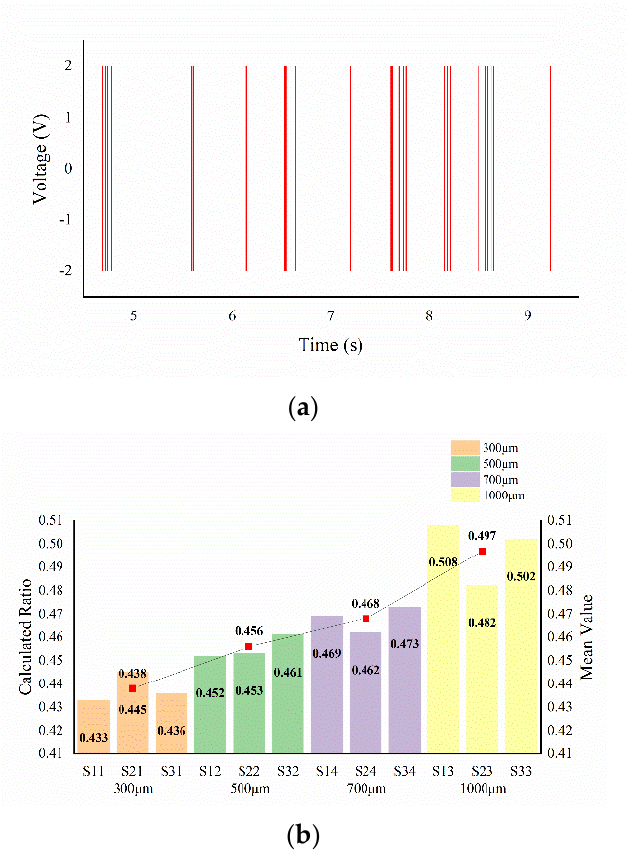
Figure 10. Experimental result of texture sample ridge width detection: ( a ) signal segment passed through threshold comparator; ( b ) result of ridge width